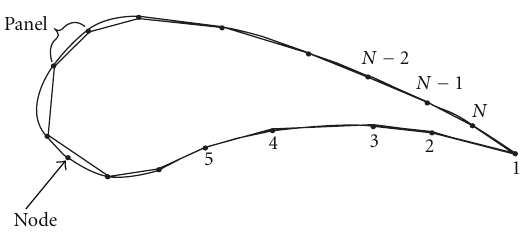
Figure 2: Nodes and